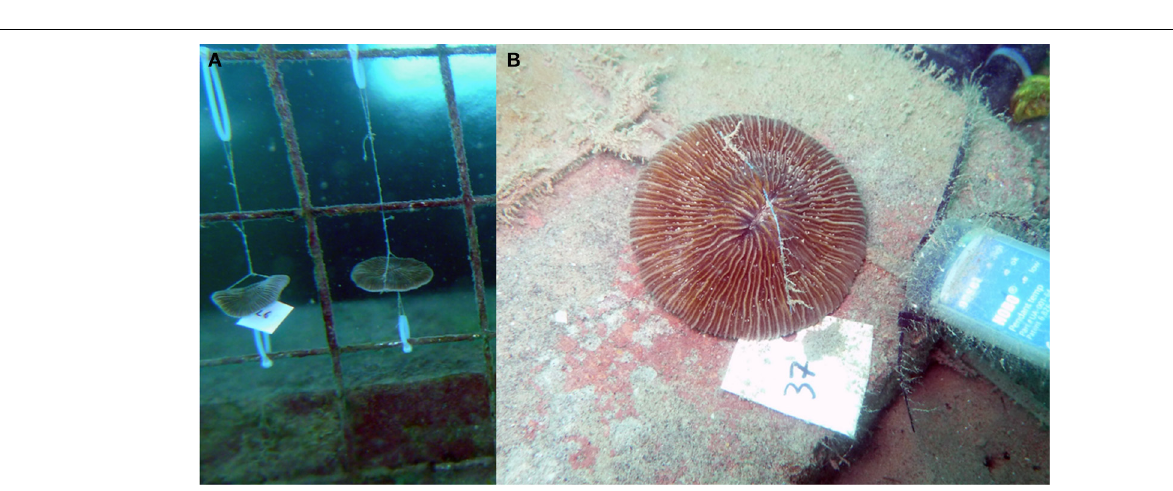
FIGURE 2 | (A) Fungia granulosa attached to the discharge screen. (B) Tagged Fungia granulosa specimen; blue temp logger visible on right hand side (station